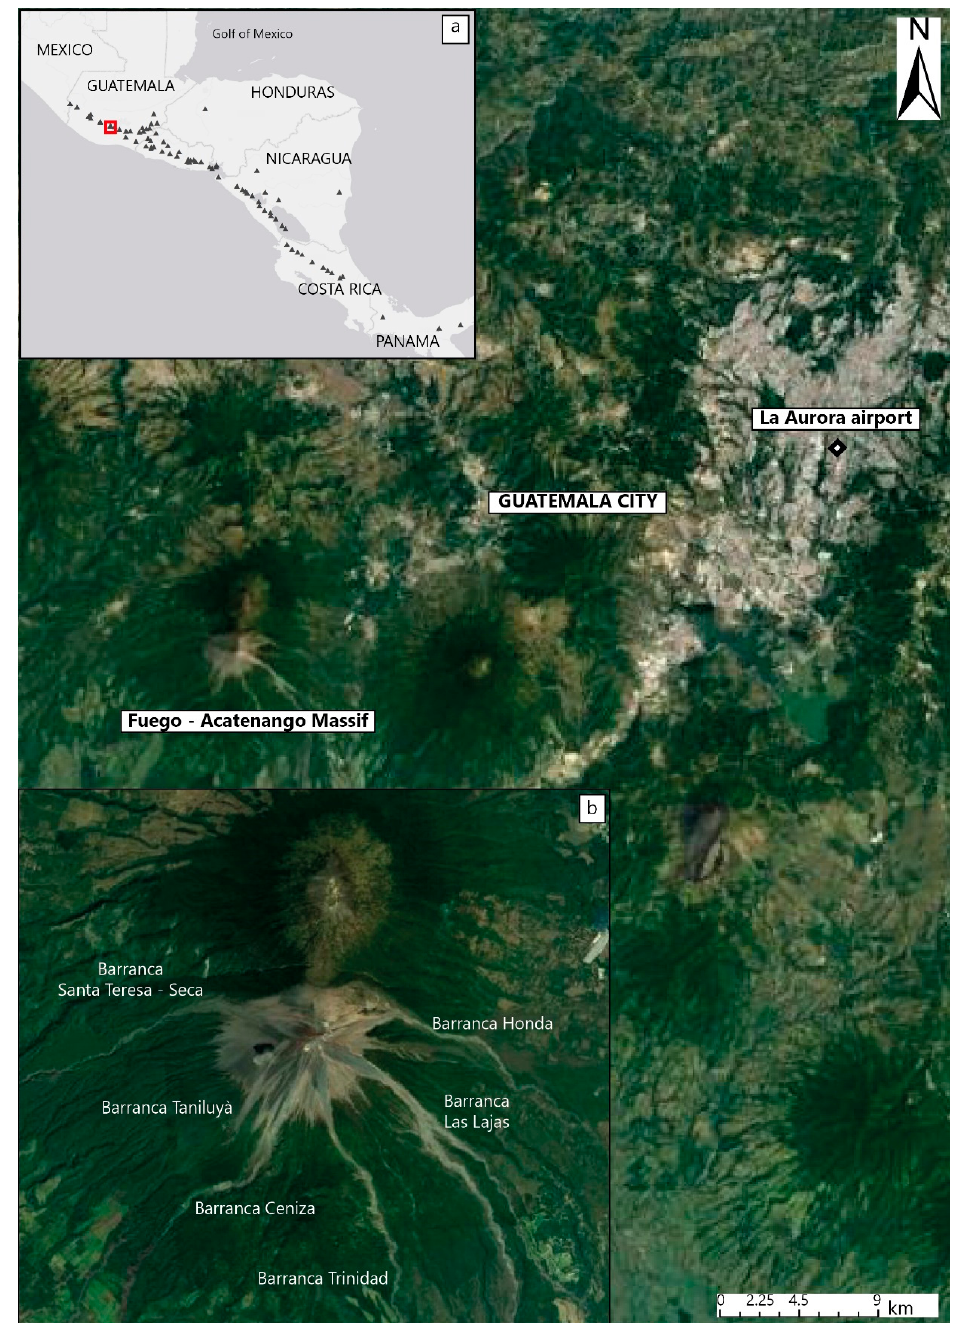
Figure 1. Location of the Fuego-Acatenango Complex. ( a ) Location of Fuego volcano in the Central American Volcanic Arc. ( b ) Detail of the main barrancas channels surrounding the Fuego edifice.